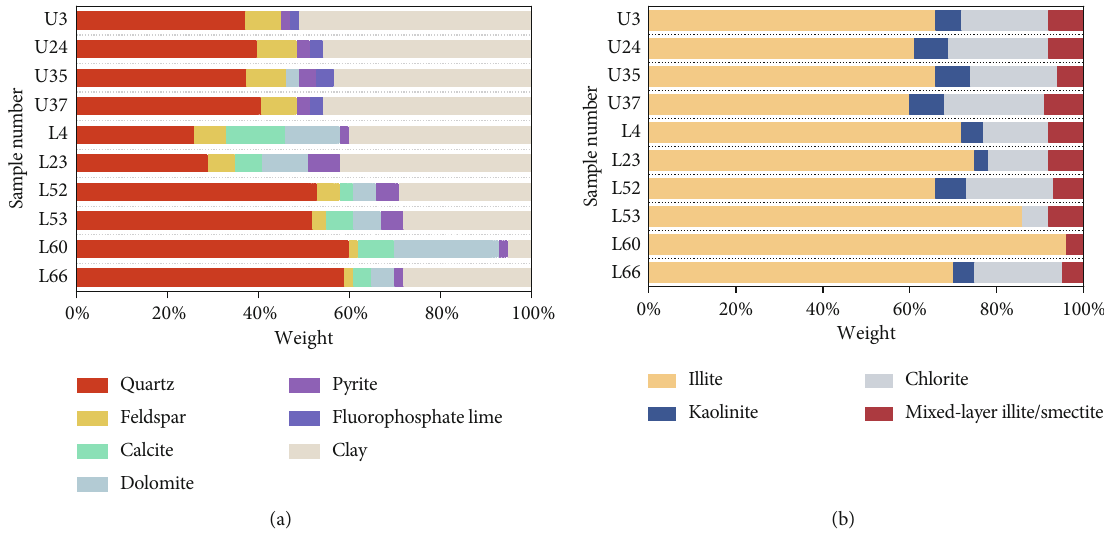
Figure 4: Mineral composition (a) and clay composition (b) of target shale samples in Longmaxi